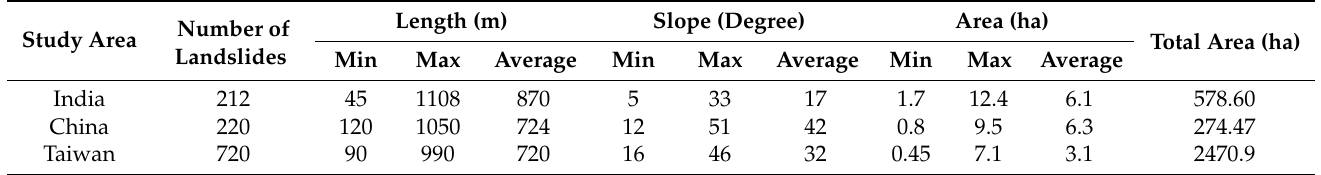
Table 1. Landslide statistic information of each study